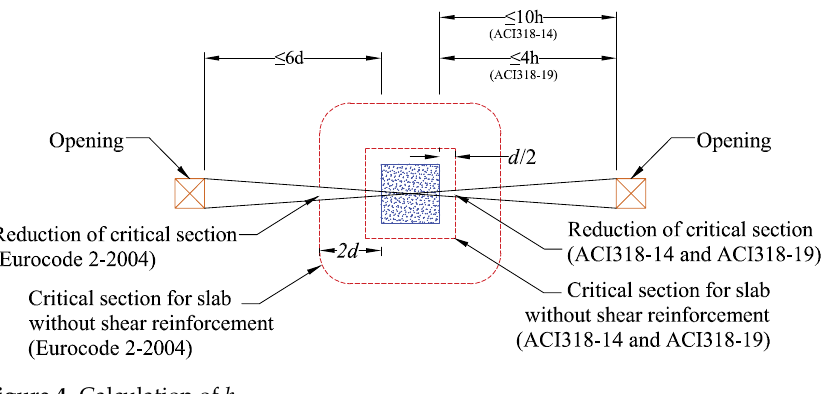
Figure 4. Calculation of b 0 .